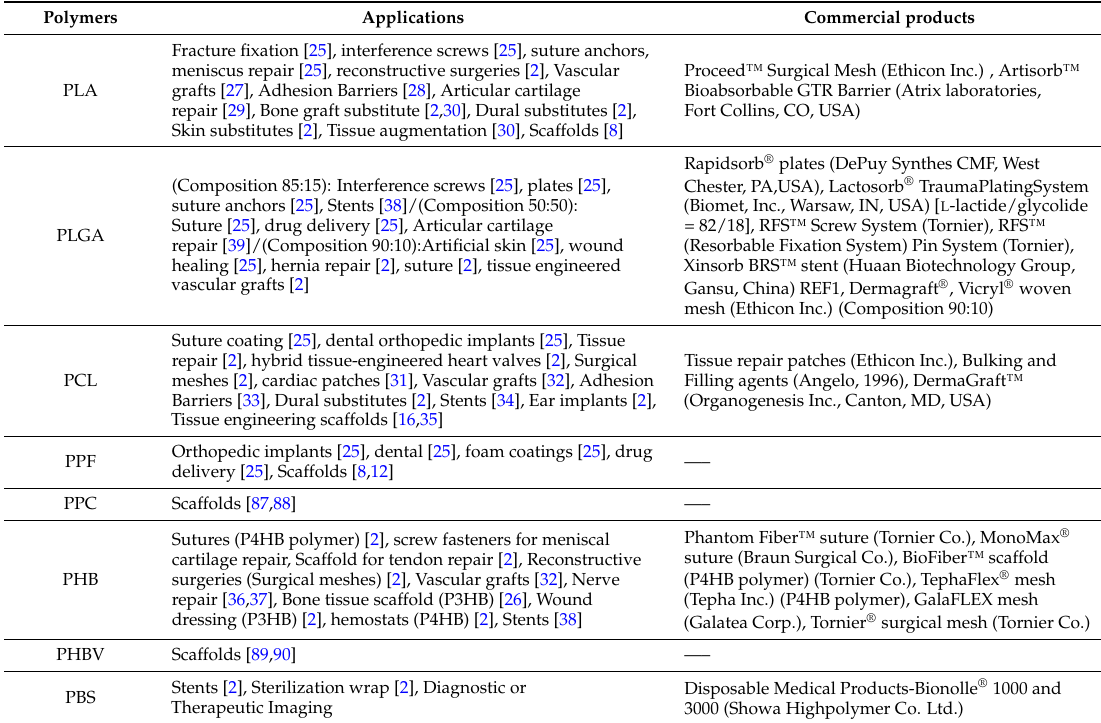
Table 3. Commercial products made from biodegradable polyesters and their applications. Polymers Applications Commercial